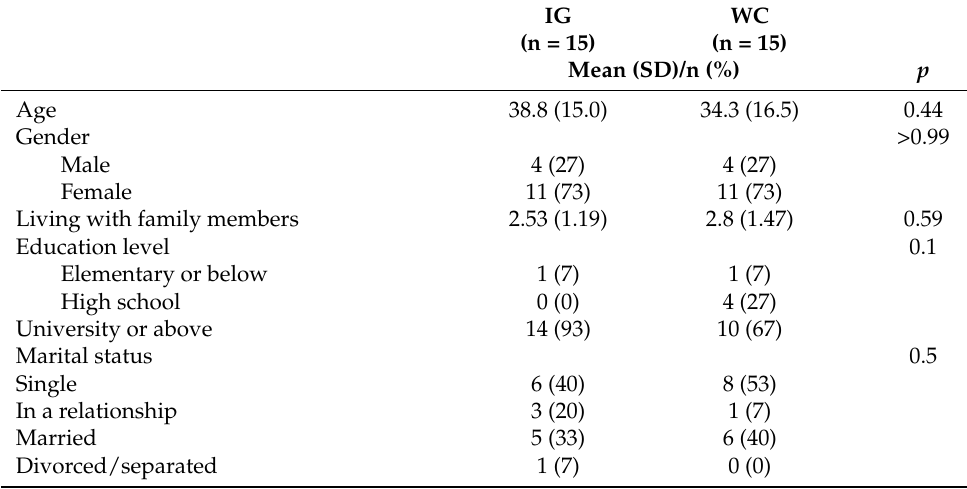
Table 1. Sociodemographic characteristics between the intervention group (IG) and the waitlist control (WC) group (N =